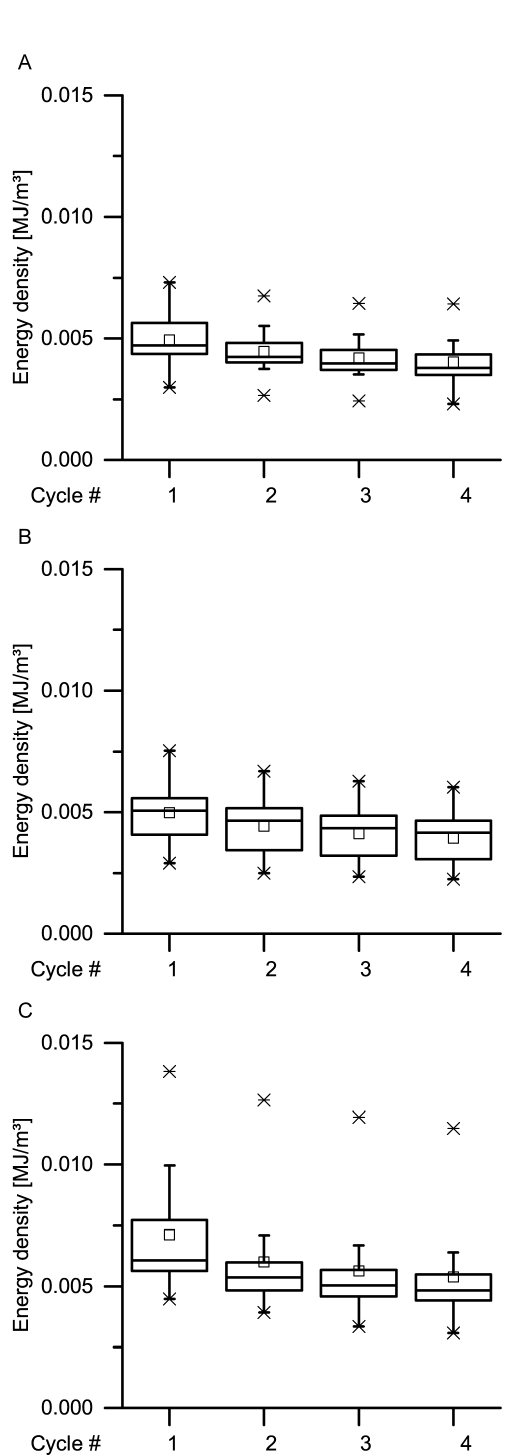
Figure A2. Energy densities of the unloading curves (released energy E r ) of the quasistatic cyclic compressiontestswithunchangedmaximumcompression, atstrainratesof0.01min − 1 ( A ),0.1 min − 1 ( B ) and 1 min − 1 ( C ) (statistical test: Kruskal–Wallis test; n = 10 for each